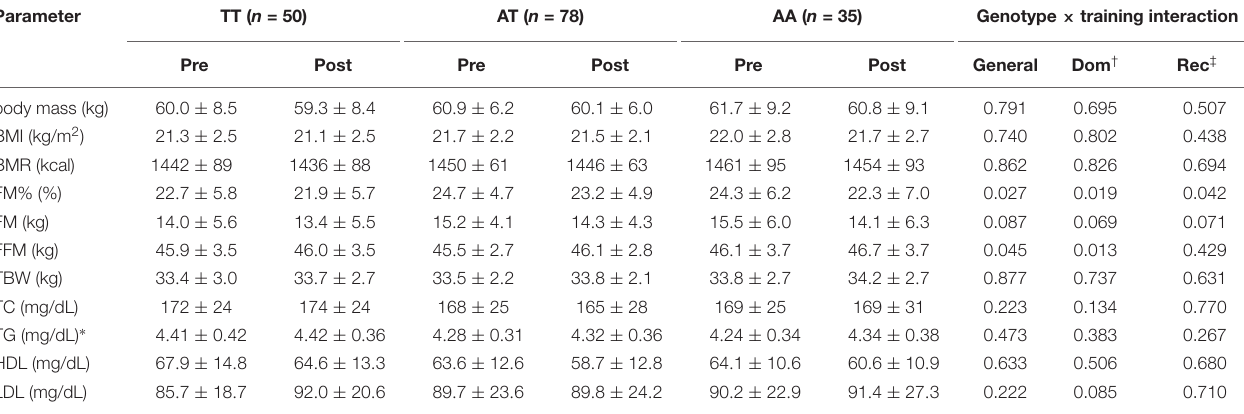
TABLE 2 | Training adaptation with respect to rs1057972 polymorphism (ANOVA with repeated measures.